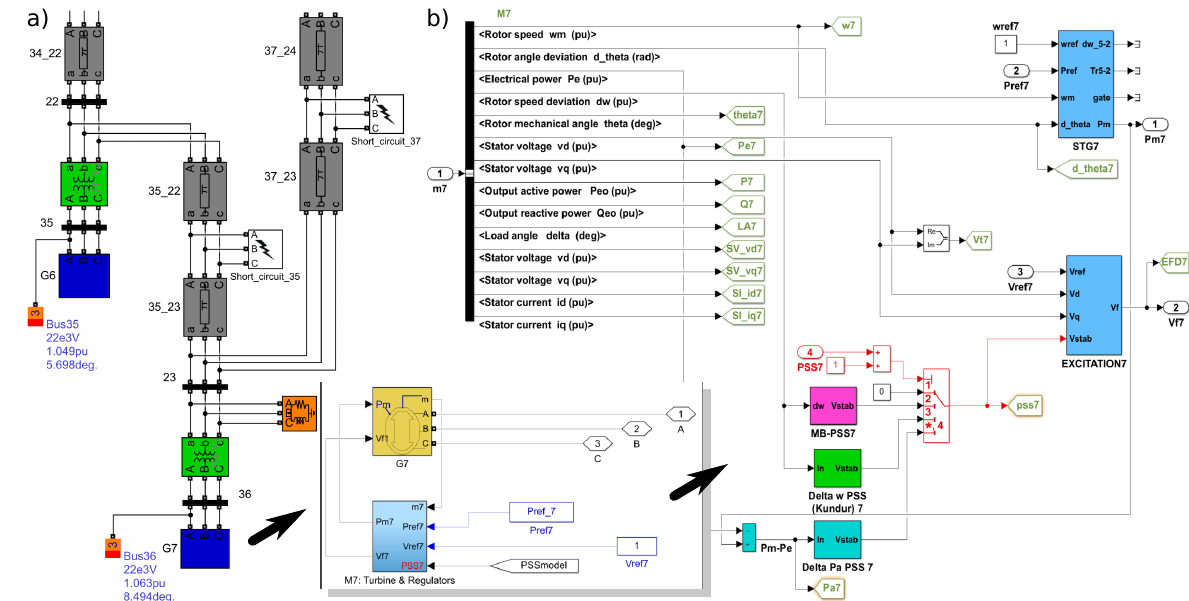
Figure 3. A view of the MATLAB/Simulink model: ( a ) detail of the power system marked by a rectangle on Figure 2, ( b ) generator G7 model’s internal components and